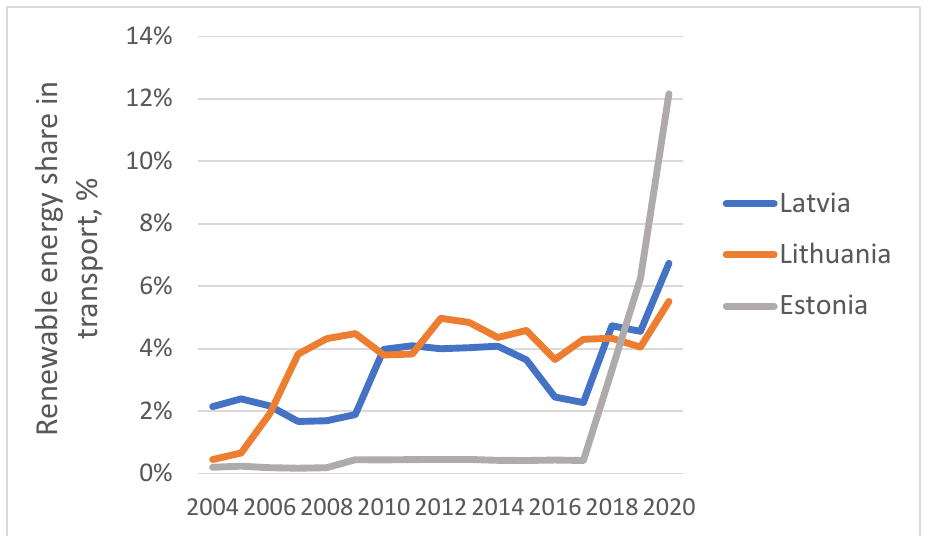
Figure 3. Dynamics of the share of renewables in transport in Baltics. Source: Created by authors. Based on Reference [44].